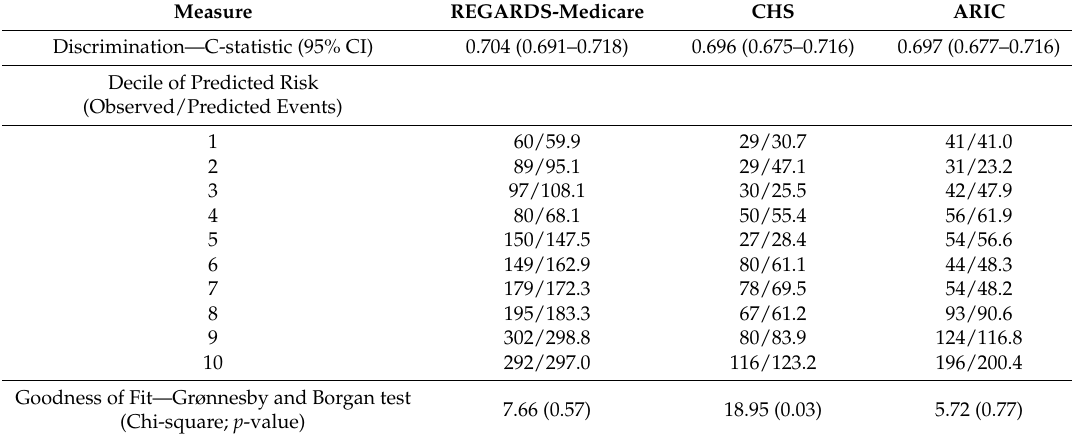
Table 4. Discrimination, calibration, and goodness-of-fit of the REGARDS-Severe Sepsis Risk Score for each